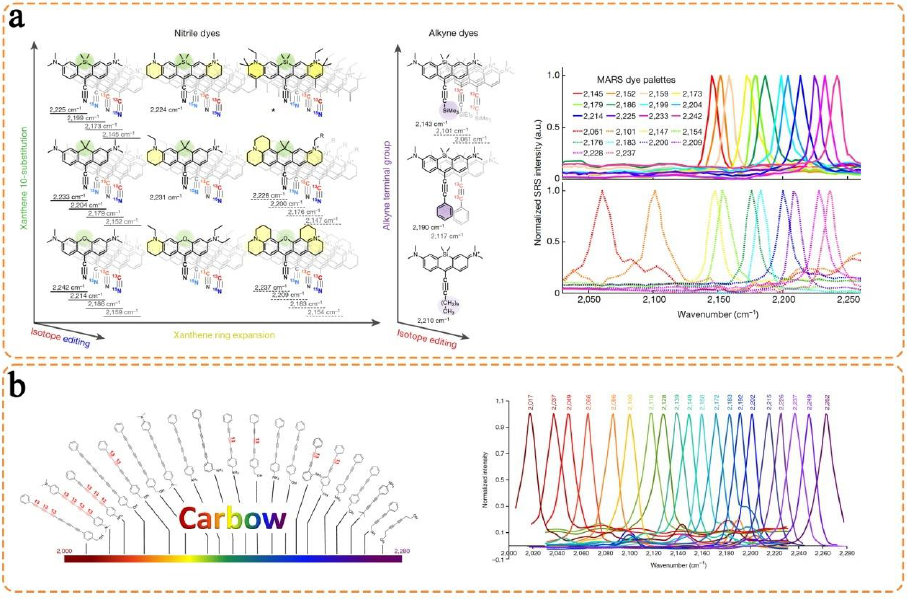
Figure 8. Designing the triple bond-modulated molecules as emerging Raman reporters to improve the multiplexing capability. ( a ) 9-Cyanopyronin-based MARS dyes to adjust Raman shift through Xanthene ring expansion, isotope editing, and alkyne terminal group control. Reproduced with permission [27]. Copyright 2017, Nature Publishing Group. ( b ) Polyyne-based “carbon rainbow” dyes with tunable Raman shift from 2000 cm − 1 to 2280 cm − 1 . Reproduced with permission [60]. Copyright 2019, Nature Publishing Group.